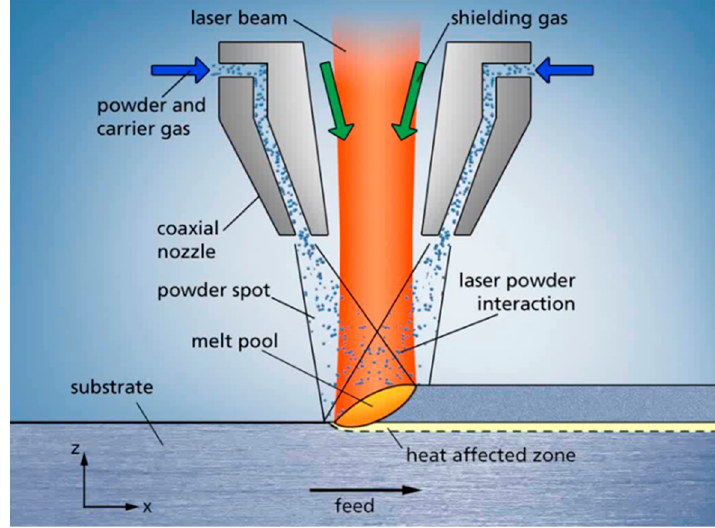
Figure 3. Powder laser metal deposition (LMD) process.